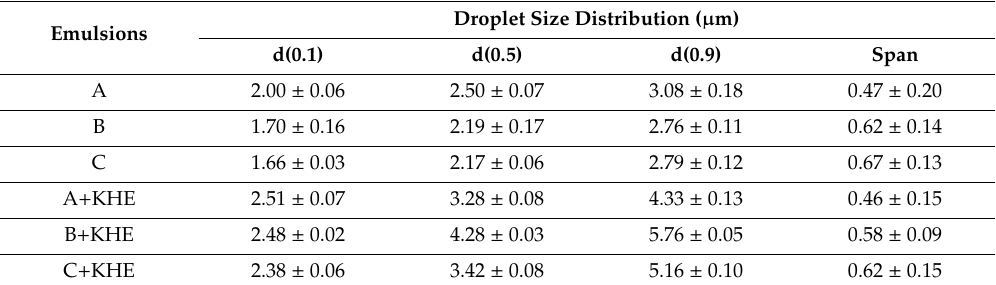
Table 3. Oil-in-gel emulsions’ droplet size distribution (mean ± SD; n =